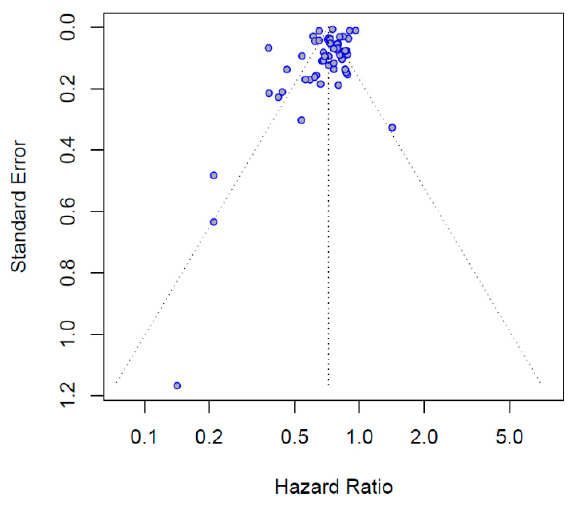
Figure 3. Funnel plot for publication bias.